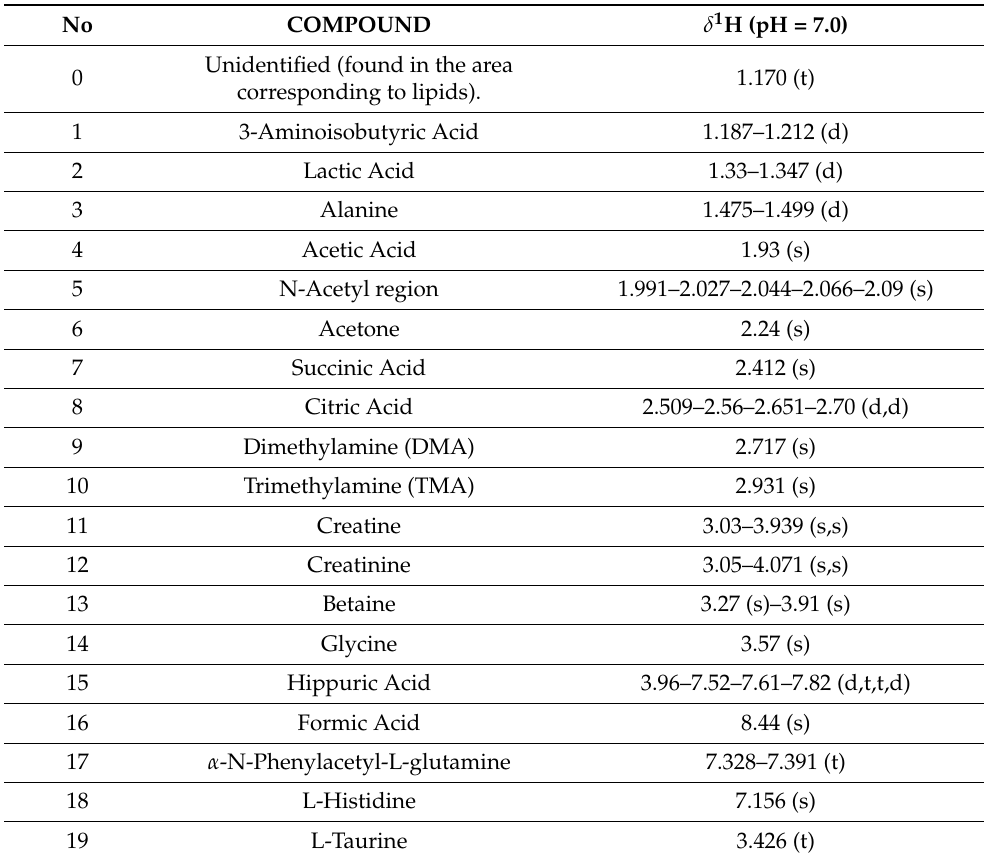
Figure 1. Average spectrum at 400 MHz of urine samples obtained from healthy individuals. Chemical families were classified into lipids, ketones, carbohydrates, amines, phenolics, aromatics, and aldehydes. Table 2. 1 H-NMR chemical shift values in ppm identified in NMR spectra for detected metabolites from healthy